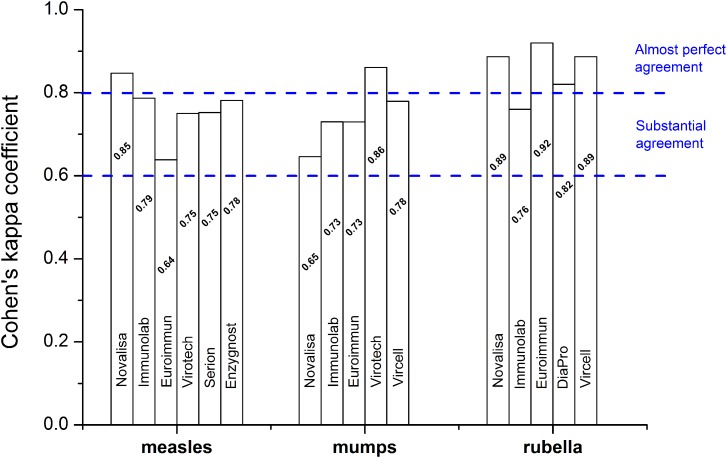
Cohen's κ analysis of plate-to-plate measurements (NNovalisa, Immunolab, Vircell = 84, NVirotech, DiaPro = 80, NEuroimmun = 88, NSerion, Enzygnost = 90 samples). The measures of agreement describing the inter-rater reliability varied between ‘substantial’ and ‘almost perfect’.